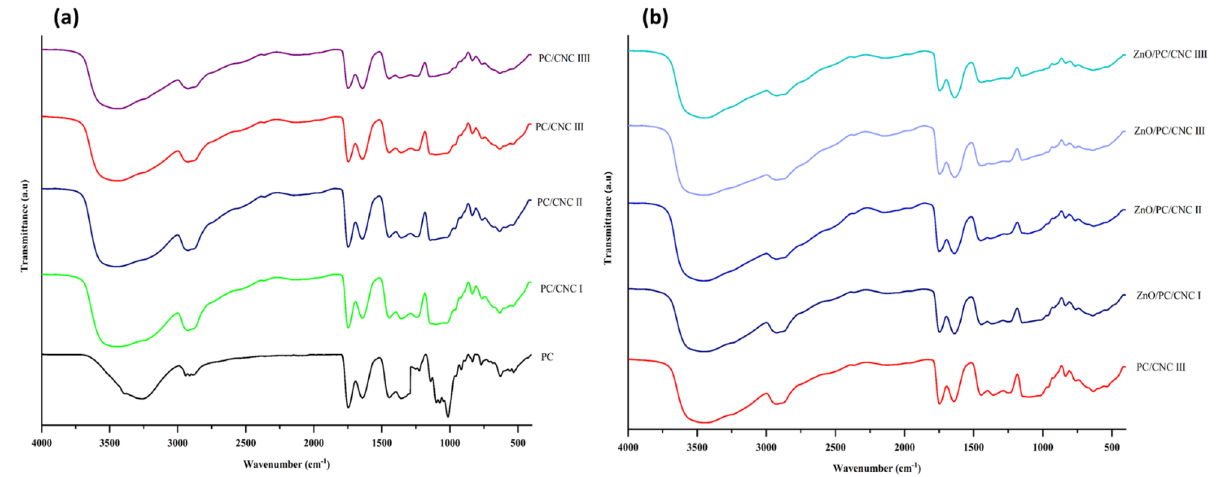
Figure 3. FTIR spectra of PC, CNC/PC ( a ) and ZnO/CNC/PC ( b ) composite